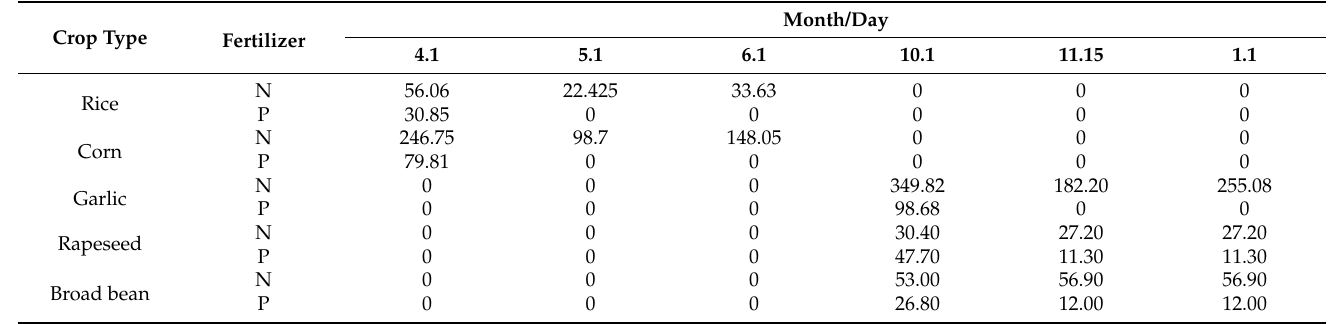
Table 2. Fertilizer management in NELB unit: kg/ha.